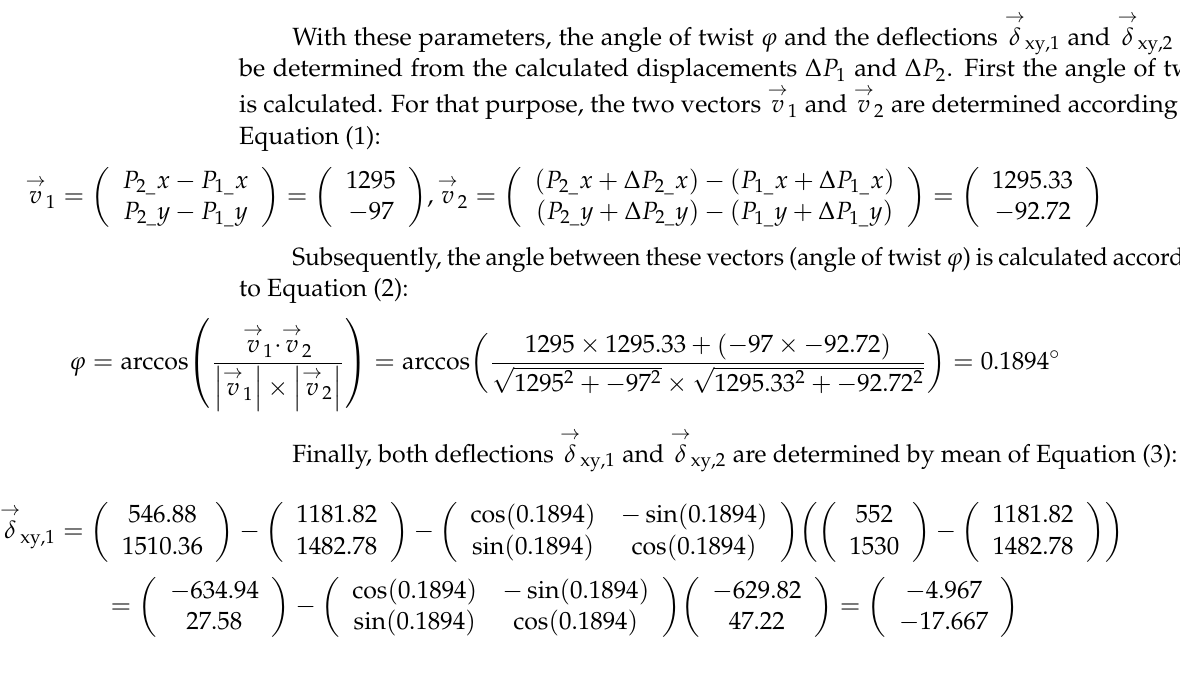
Figure 10. Initial and new positions of points 1 and 2 after multiaxial loading of the structure with ( F x + F y + M z ) and the calculated displacements ( a – c ) real displacements of P 1 and P 2 in composite